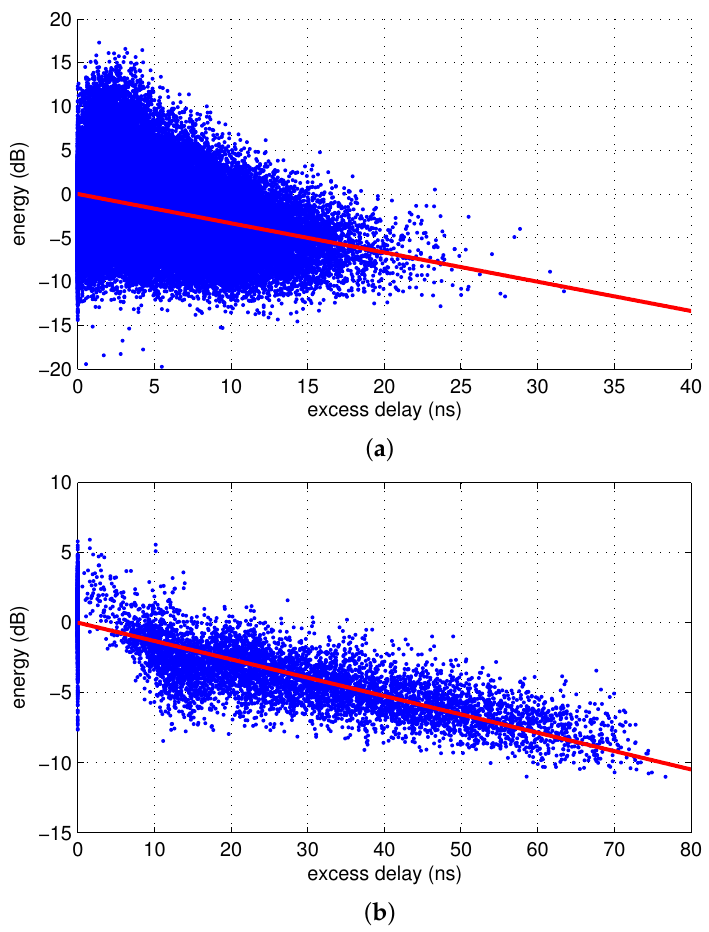
Figure 5. Scatter plots of the ( a ) ray and ( b ) cluster